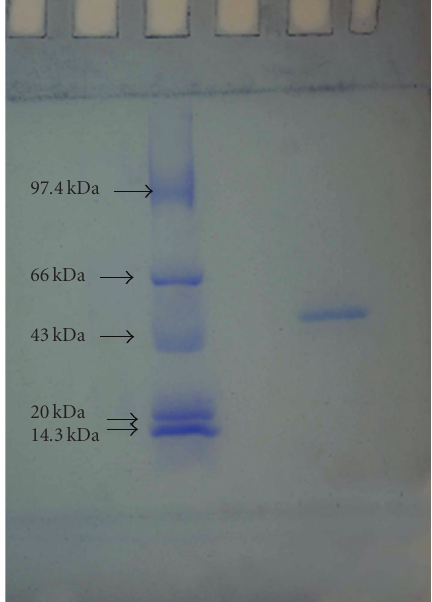
Figure 3: SDS-PAGE showing a purified band of 56